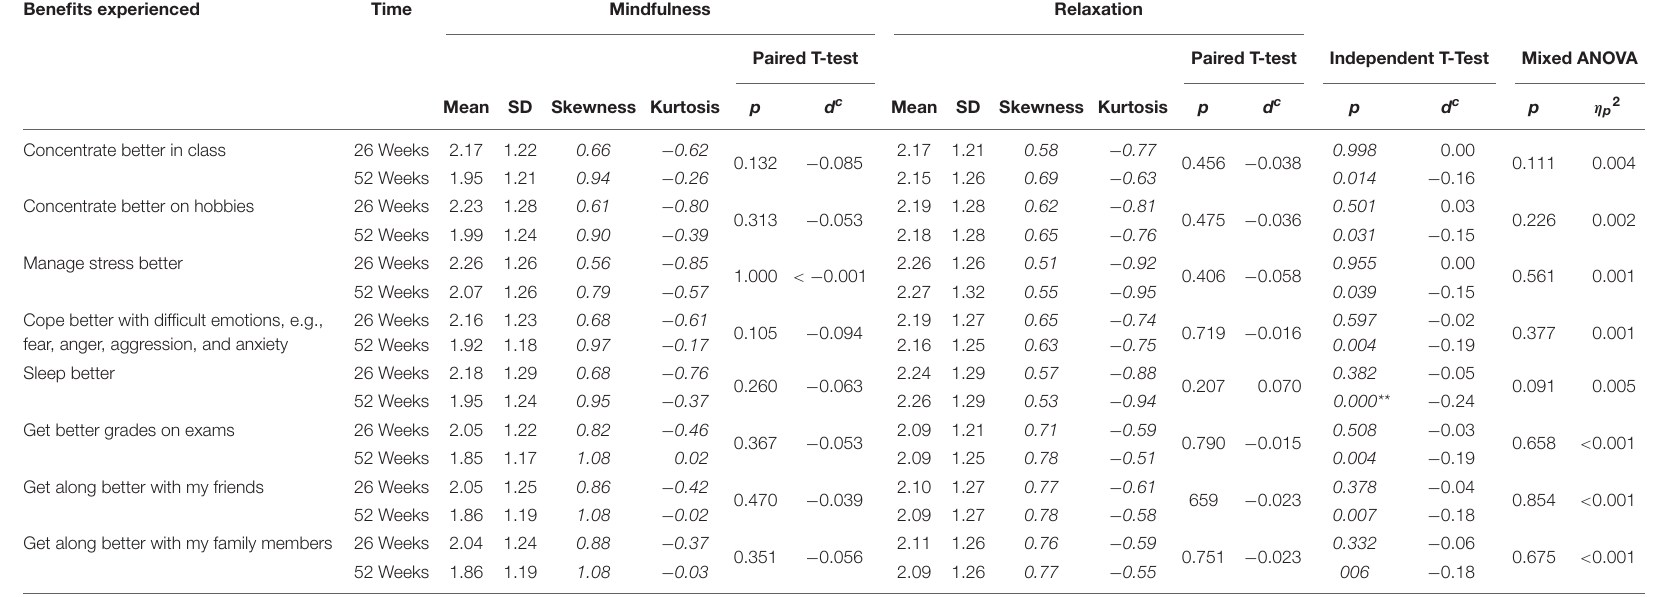
TABLE 3 | Differences in benefits experienced ab